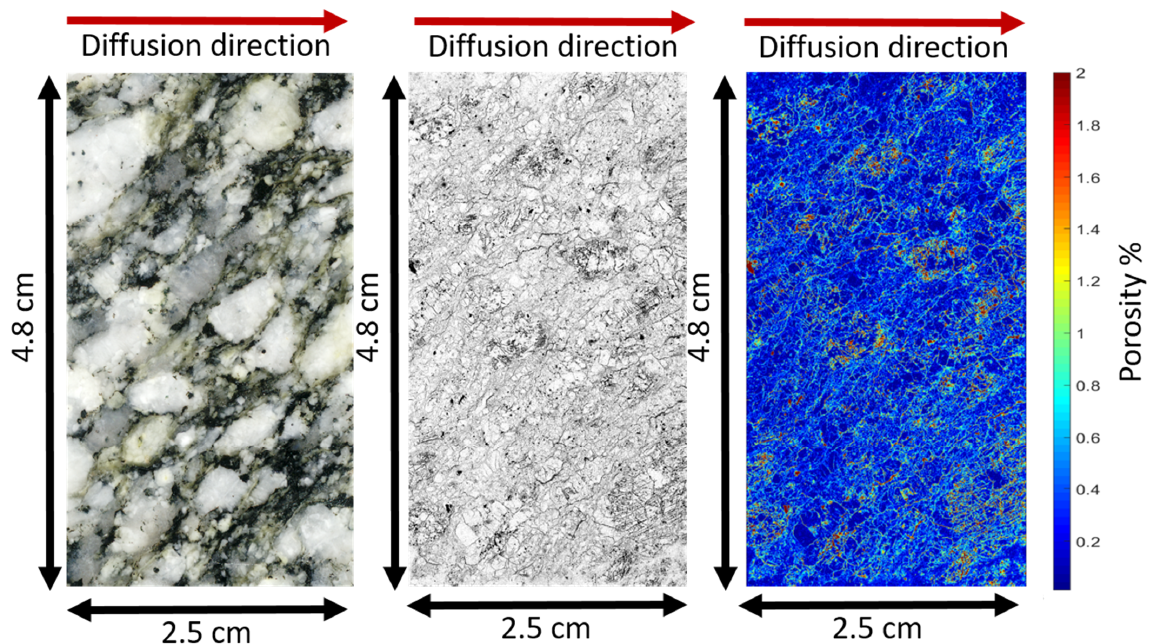
Figure 3. ( Left ): Surface scan of the autoradiography sample. ( Center ): Corresponding autora- Figure 3. Left: Surface scan of the autoradiography sample. Center: Corresponding autoradiograph. Right: Corresponding diograph. ( Right ): Corresponding porosity map. The diffusion direction in the electromigration porosity map. The diffusion direction in the electromigration experiment was from left to right. experiment was from left to right.